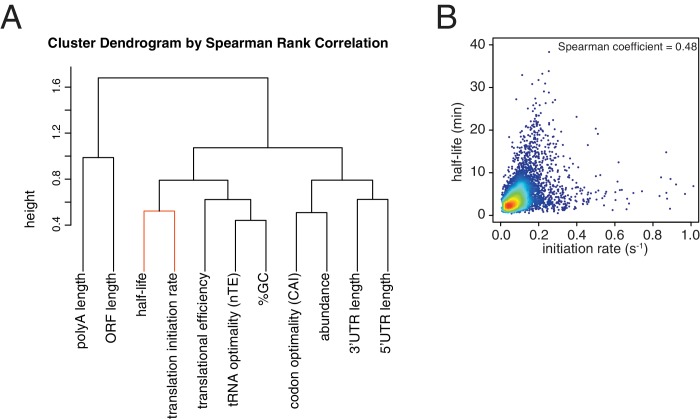
Correlation between translation initiation rate and aspects of mRNA structure and function.(A) Dendrogram of the Spearman rank correlation coefficients between transcriptome-wide datasets. Clustering was based on Euclidian distances. The close clustering between half-life and translation initiation rate is highlighted in orange. (B) Scatter plot of half-life values against estimated translation initiation rates. Color indicates density of datapoints as in Figure 1—figure supplement 1C.